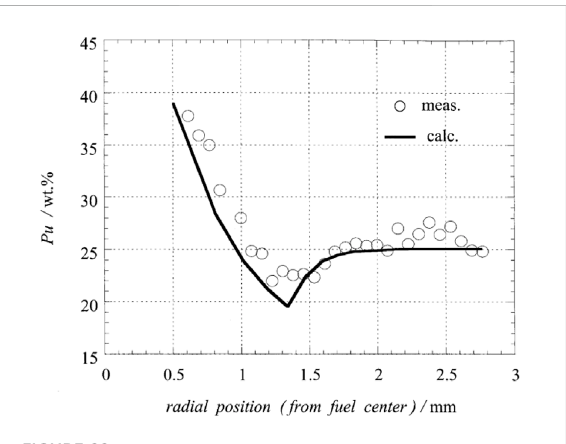
FIGURE 22 Radial distribution of plutonium predicted by CEDAR model and comparison of experimental data (experimental data from XD0992 fuel rod with 11 at% burnup, initial oxygen/metal ratio of 1.99,andinitialplutoniumcontentof27 wt%)(IshiiandAsaga, 2001).